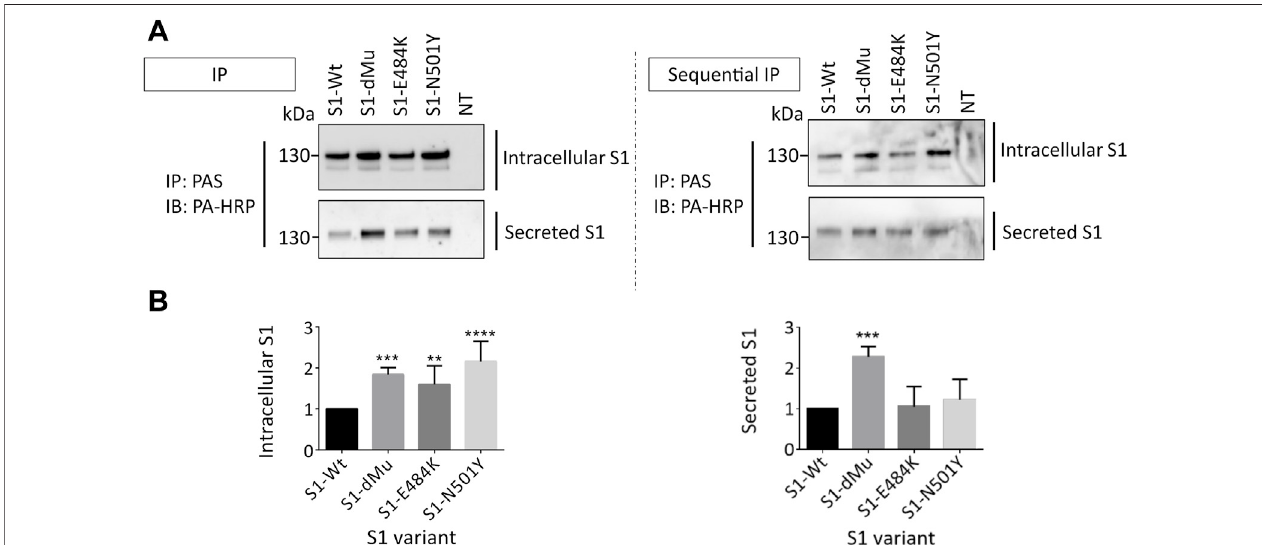
FIGURE3| dMu, E484K,and N501Yvariants ofS1arecomparatively highly expressed and secreted inCOS-1 cells. (A) TransfectedCOS-1 cellswerelysed48 h after transfection. Equal protein-containing lysates (upper left blot) and collected media (lower left blot) of each S1 mutant were pulled down using protein A-bound Sepharose (PAS) and analyzed using SDS-PAGE on 8% slab gels. To con fi rm these expression pro fi les, we carried out parallel sequential immunoprecipitation of both lysates(upperrightblot)andmedia(lowerrightblot),whichre fl ectedhigherintracellularandsecretoryproteinlevelsinthecaseofS1-dMuandS1-N501Y mutants. (B) ComparisonbetweenrelativeexpressionlevelsofS1variantsinCOS-1cells(leftbargraph)andtheirsecretoryproteinscollectedfromthemedia(rightbargraph)( n = 4). Data are normalized to the wild type and expressed as arbitrary